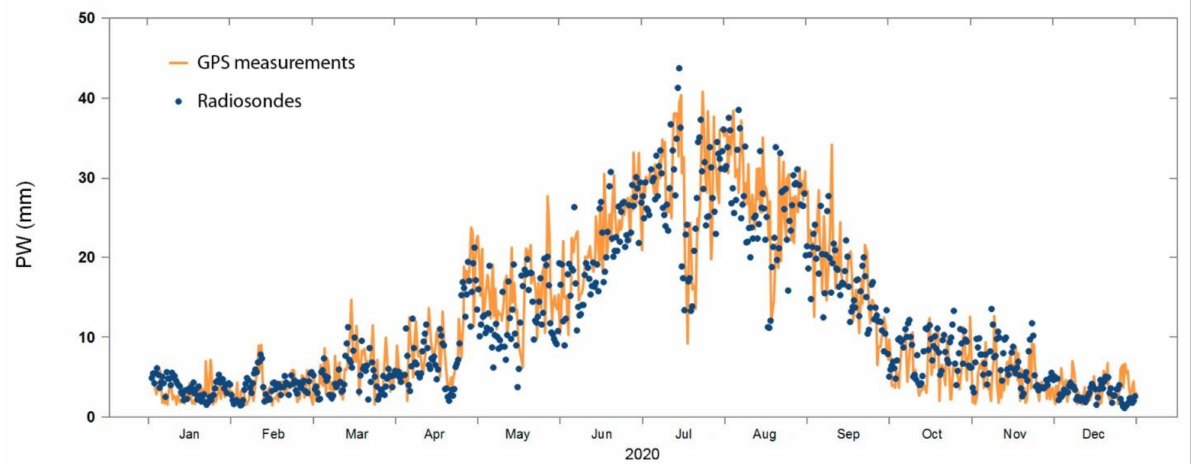
Figure 3. Comparison of values of the moisture content of the low atmosphere above the observation point IRKM (Irkutsk) according to the data of GPS measurements and radiosondes during